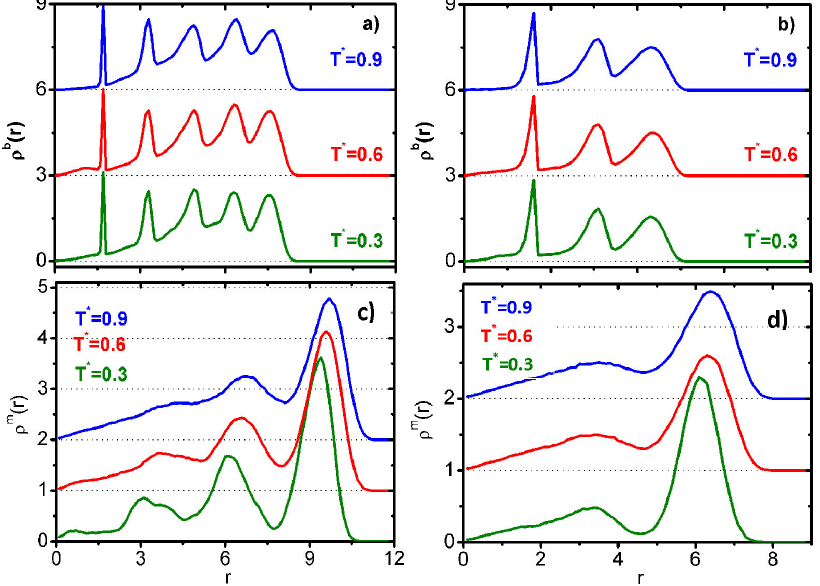
Figure 7. Radial distribution of monomers about the center of mass of LCDrs. ( a ) G D D D ( b ) G ; ( c ) G ; and ( d ) G . In all plots, the traces are offset for clarity; horizontal 3 5 5 3 3 5 dashed lines show zero levels for the